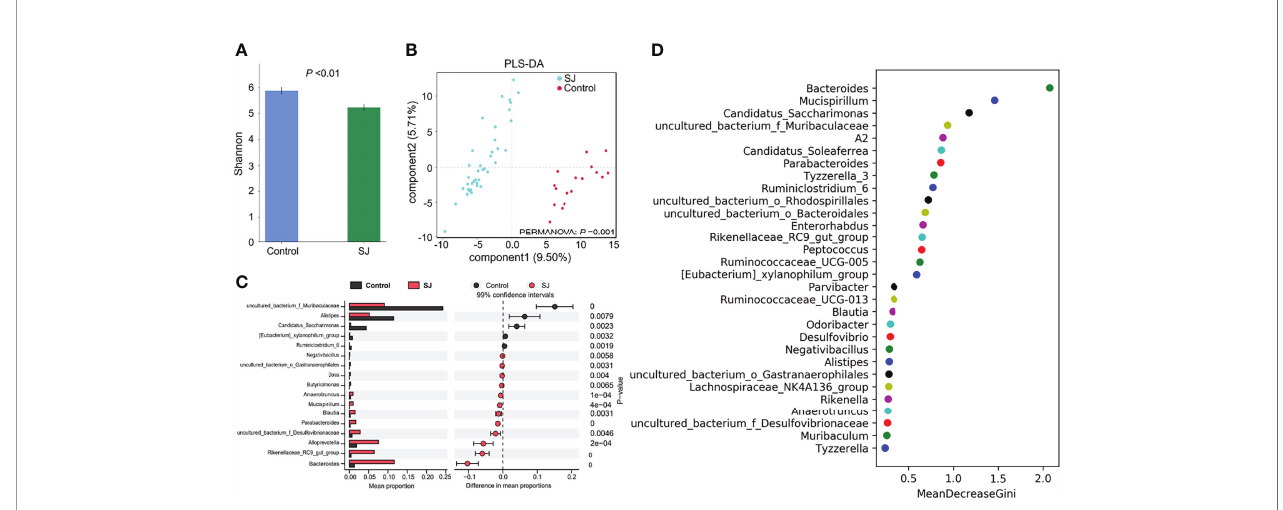
FIGURE 2 | Taxonomic differences of gut microbiota between S. japonicum- infected (n=39) and uninfected (n = 17) mice. (A) Shannon index. (B) PCoA plot. (C) The difference of gut microbes in mice at the genus level using STAMP. (D) Top 30 of different gut microbes between populations are shown . Control, without S. japonicum infection mice. SJ, S. japonicum- infected